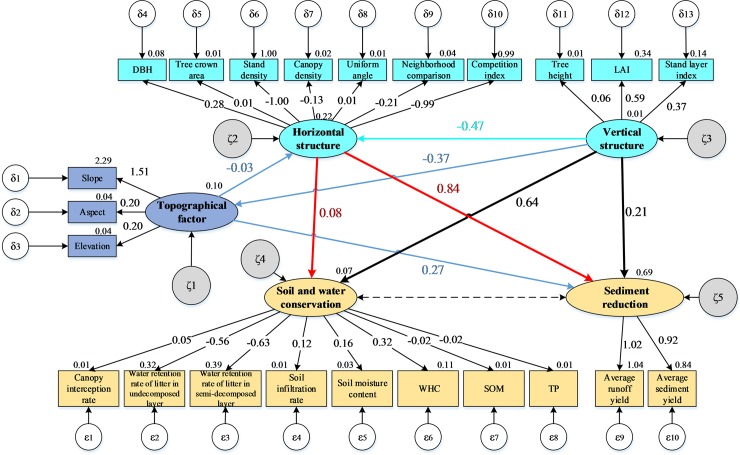
The initial structural equation model of the coupled relationships between the stand structure and the soil and water conservation functions of Robinia pseudoacacia L.Notes: aThe hypothesized initial model used to predict the topographical factors, horizontal structure, vertical structure, soil and water conservation, and sediment reduction is based on soil and water conservation science and general experience. bA rectangular box is used for each observed variable, including the measurement errors, and the numbers on the single arrows correspond to the standardized path coefficients of the initial model. Values outside the rectangular boxes are the means of the indicators, and values outside the ovals are the residual errors before modification. cIn Figs 3 and 4, DBH is the acronym for diameter at breast height; LAI is the abbreviation for leaf area index; WHC is the acronym for soil maximum water holding capacity; SOM is the abbreviation for soil organic matter; and TP is the acronym for total phosphorus.